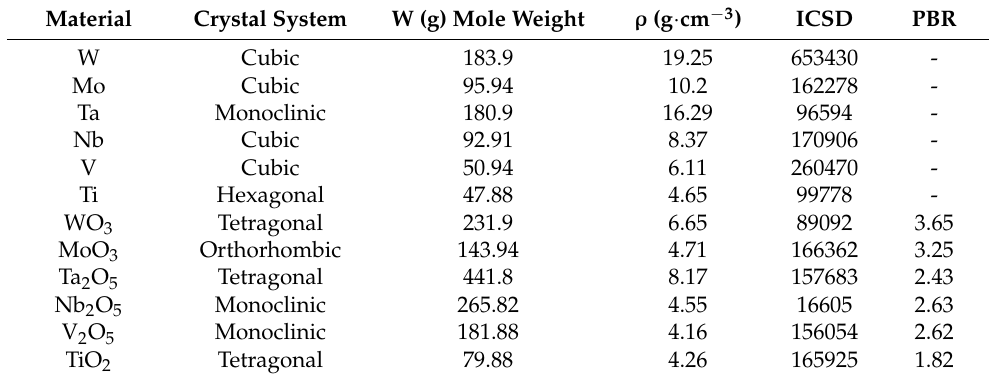
Figure 3. XRD patterns of the oxide scales formed on three alloys after different oxidation times at 1000 °C. Table 3. Data used to calculate PBR and the PBR values of corresponding oxides.